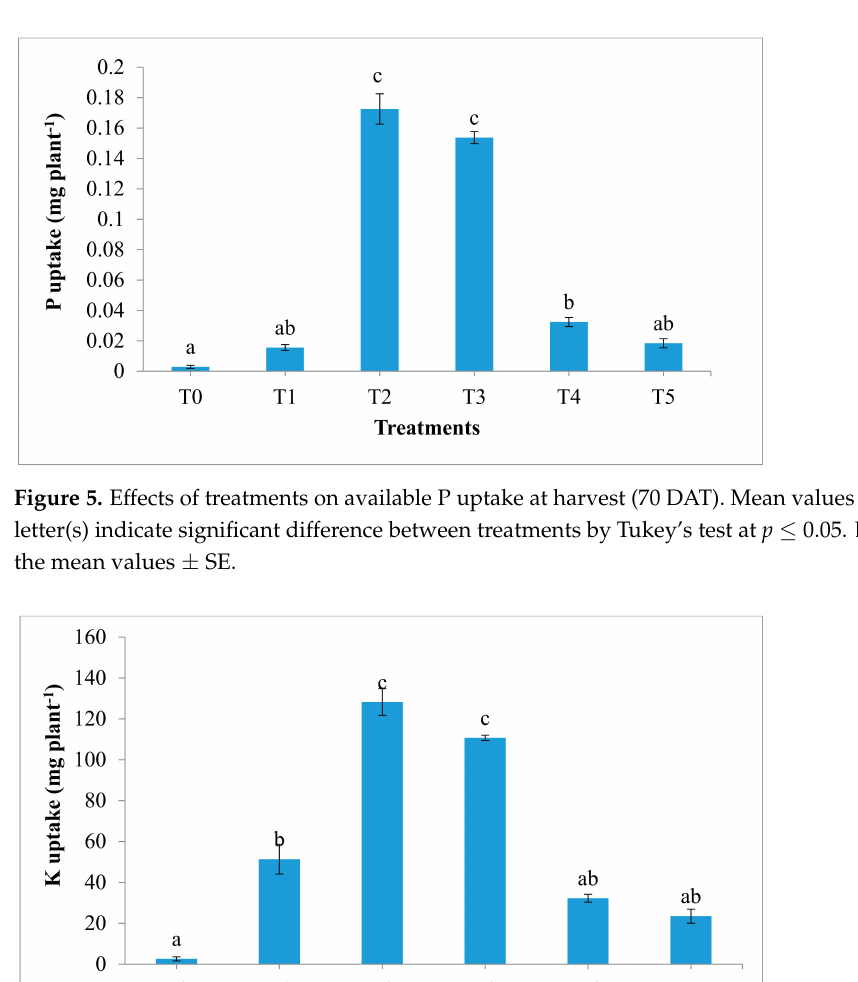
Figure 4. Effects of treatments on total N uptake at harvest (70 DAT). Mean values with different letter(s) indicate significant difference between treatments by Tukey’s test at p ≤ 0.05. Bars represent the mean values ± SE.